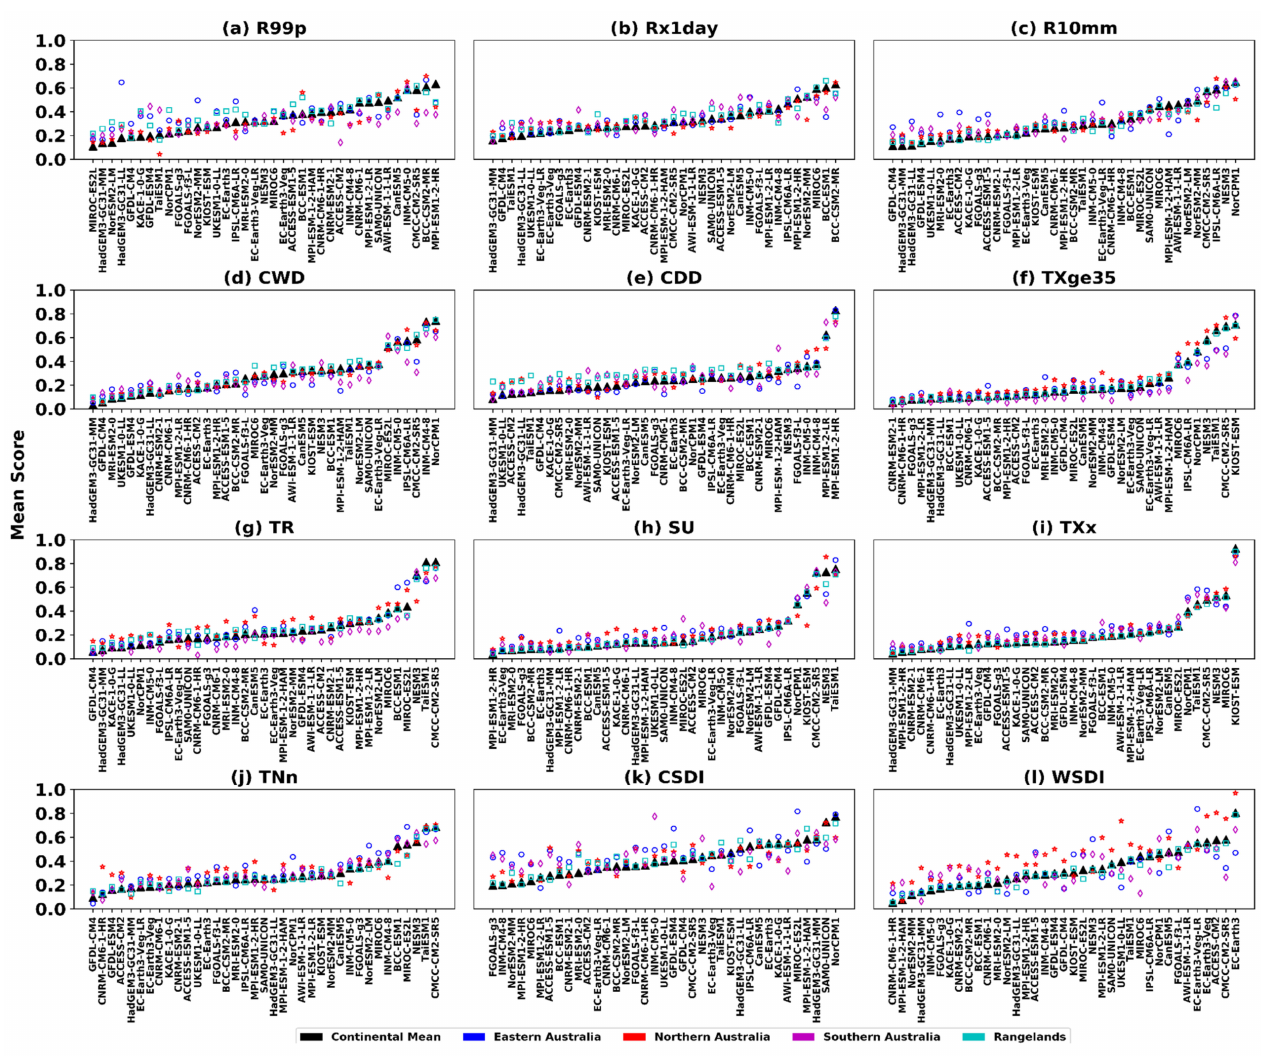
Figure 15. Spatially averaged normalised scores of the GCMs for the extreme indices ( a ) total an- nual precipitation from very heavy rain days (R99p), ( b ) maximum 1-day precipitation (Rx1Day), ( c ) number of very heavy rain days (rain > 10 mm) (R10mm), ( d ) consecutive wet days (CWD), ( e ) consecutive dry days (CDD), ( f ) number of days when maximum temperature is greater than 35 ◦ C (Txge35), ( g ) tropical nights (number of days when minimum temperature > 20 ◦ C) (TR), ( h ) summer days (number of days when maximum temperature > 25 ◦ C) (SU), ( i ) maximum maximum-temperature (TXx), ( j ) minimum minimum-temperature (TNn), ( k ) annual count of nights with at least 4 consecutive nights when daily minimum temperature < 10th percentile (CSDI) and ( l ) annual count of days with at least 4 consecutive days when daily maximum temperature > 90th percentile (WSDI). Here, the smaller score values correspond to the better performance of GCMs. Also, for each extreme index, GCMs are arranged from best to worst performance as we move from left and right. Here black, blue, red, magenta and cyan colours denote means over the continent, eastern Australia, northern Australia, southern Australia and rangelands. The markers denote the continental (triangle), northern Australia (star), eastern Australia (circle), southern Australia (diamond) and rangelands (square) values. Data spans